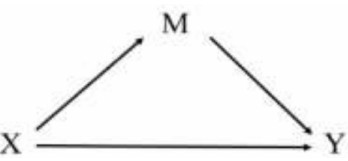
Figure 1. The relationship between X (e.g., SNPs), M (e.g., Al concentrations), and Y (e.g., eGFR) using a mediation